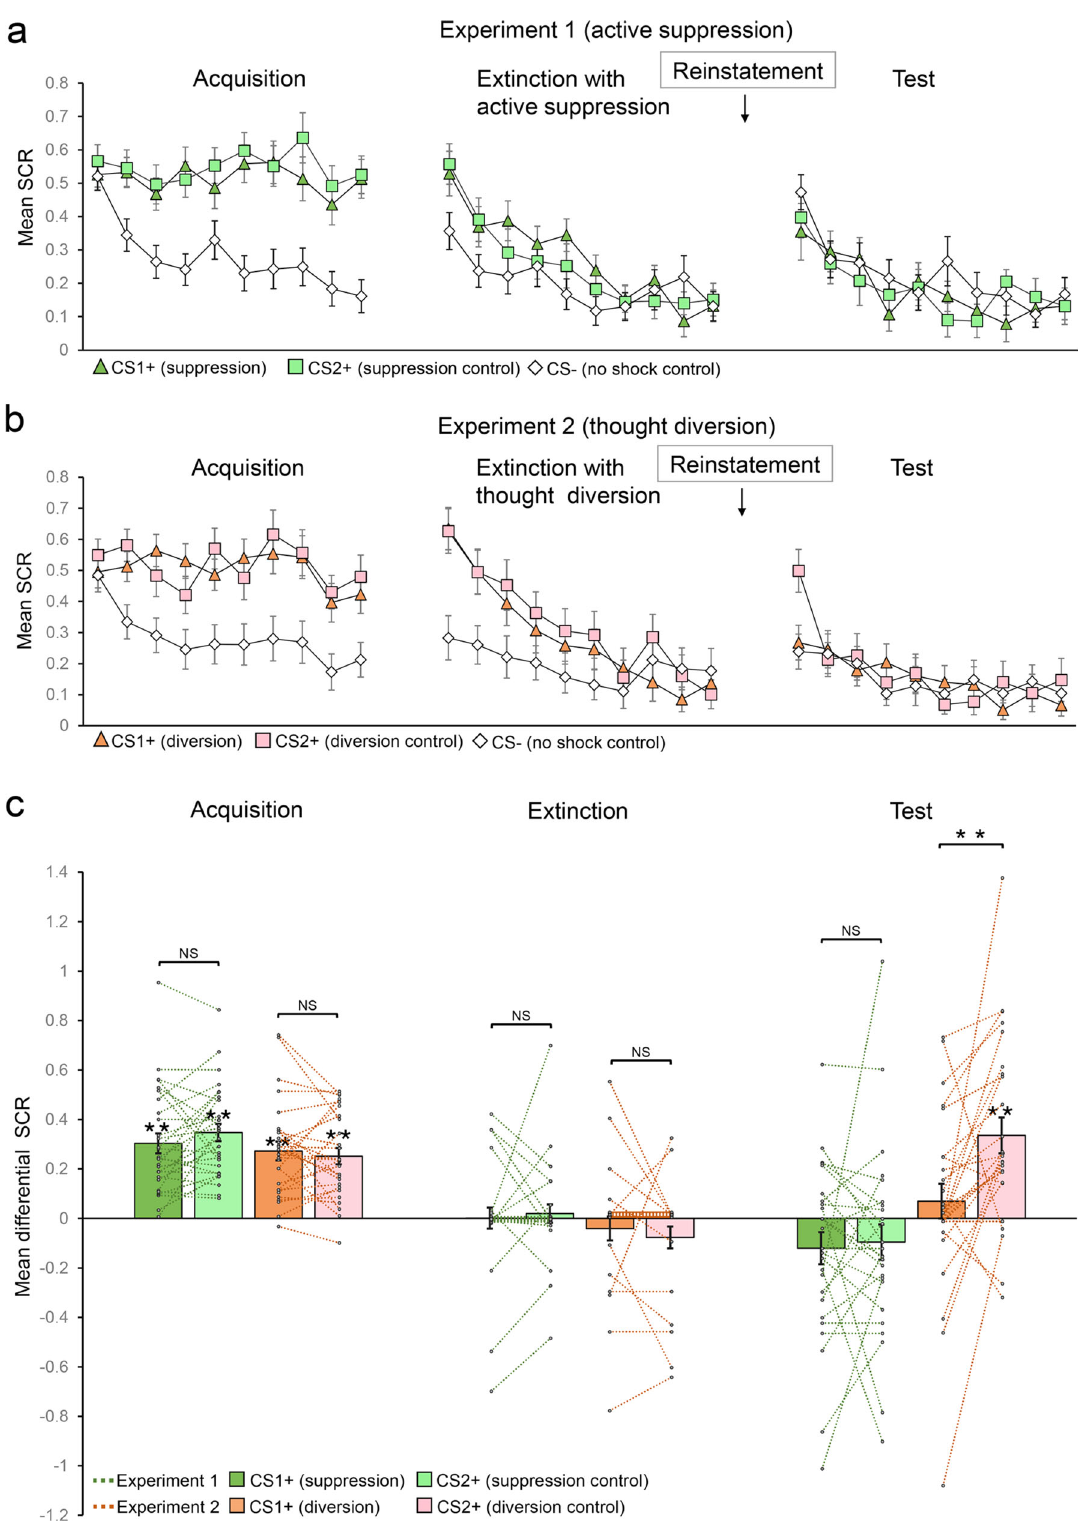
Fig. 2 SCR responses to conditioned stimuli in both experiments. a Mean SCRs of fear conditioned stimuli CS1 + (suppression) and CS2 + (suppression control), and the no-shock control stimulus (CS – ) across fear acquisition, extinction, and test phases in Experiment 1 (active suppression). b Mean SCRs of fear conditioned stimuli CS1 + (diversion) and CS2 + (diversion control), and the no-shock control stimulus (CS – ) in Experiment 2 (thought diversion). c Mean differential SCRs (CS1 + minus CS – , and CS2 + minus CS – ) in acquisition (late phase), extinction (last trial), and test phases (plotted as fear recovery index: the difference between the fi rst test trial and the last extinction trial for CS1 + and CS2 + of both experiments). ** P < 0.001. NS non-signi fi cant. Error bars represent standard